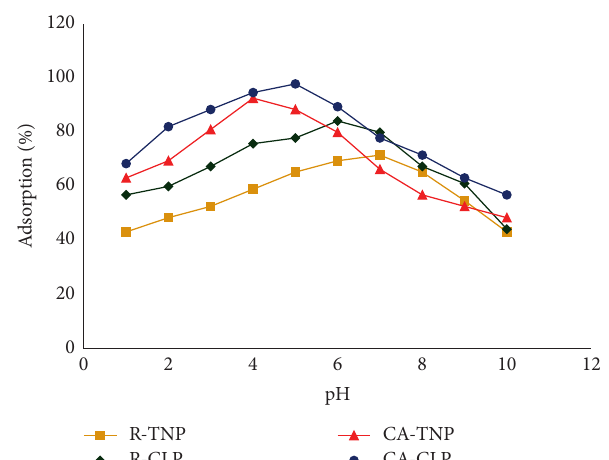
Figure 11: Effect of pH on the adsorption process. Experimental conditions: pH range 1 to 10, conc. � 25 ppm, volume � 25mL, adsorbent dose � 0.6g, contact time � 30min, temperature 30 ° C, and agitation speed � 100rpm.